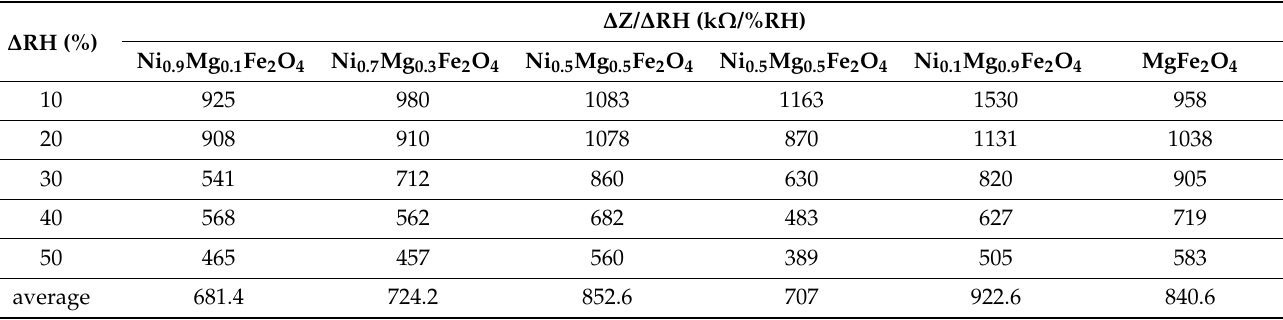
Table 4. Sensitivity of Ni x Mg 1-x Fe 2 O 4 samples in the RH range of 40–90%, calculated as ∆ Z/ ∆